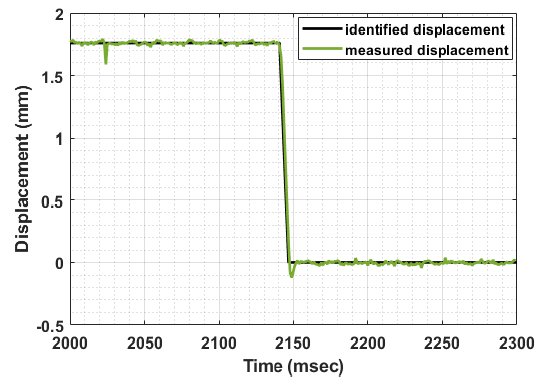
Figure 15 Current analysis when the solenoid is energized and the corresponding indicated displacement.